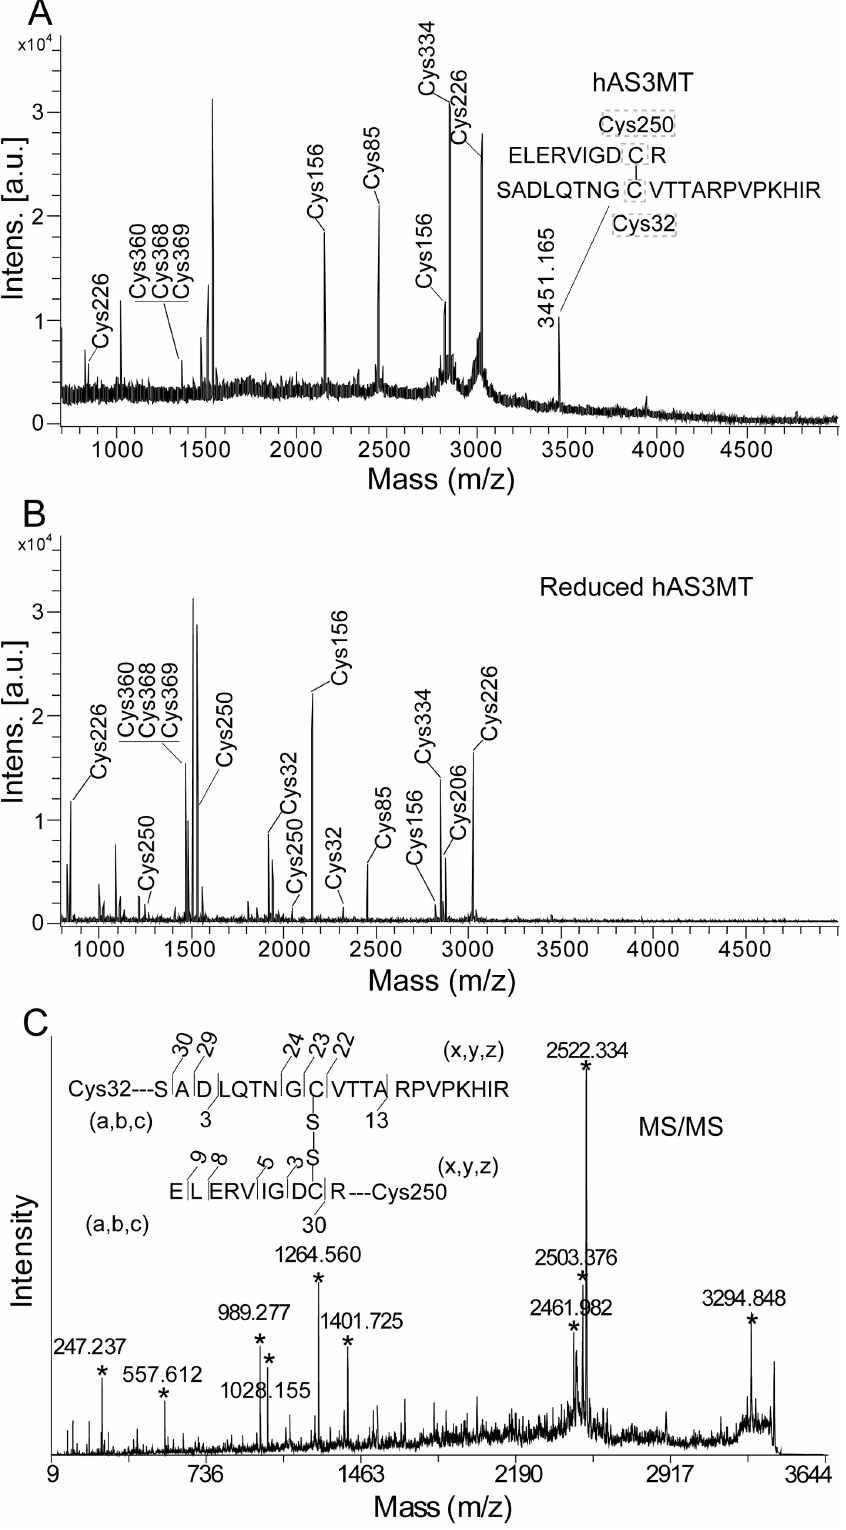
Figure 1. MALDI-TOF-MS spectra of the tryptic digests of hAS3MT (A) and its reduced form (B). (C) MS/MS spectra for the sequence at 3451.17 (m/z). Labels a, b, c, x, y, and z represent the cleavage manners of peptides.